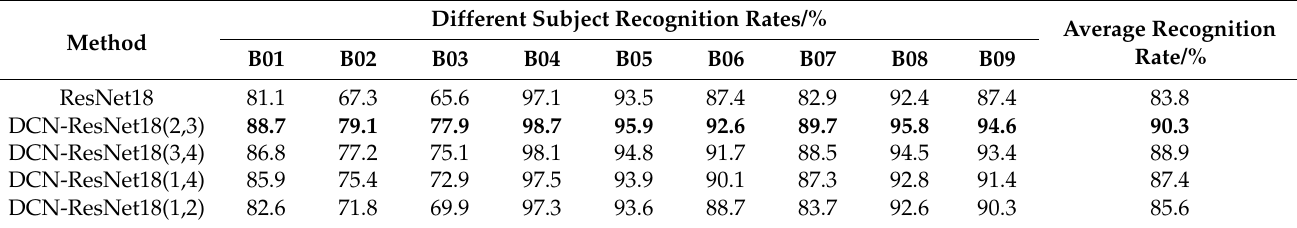
Table 5. Different network structure recognition accuracy rate.